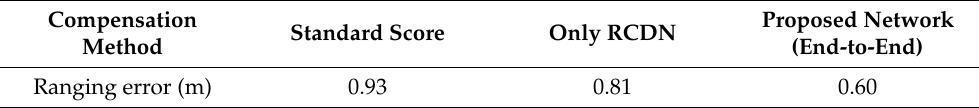
Table 1. Estimated RTT distance errors with respect to each compensation